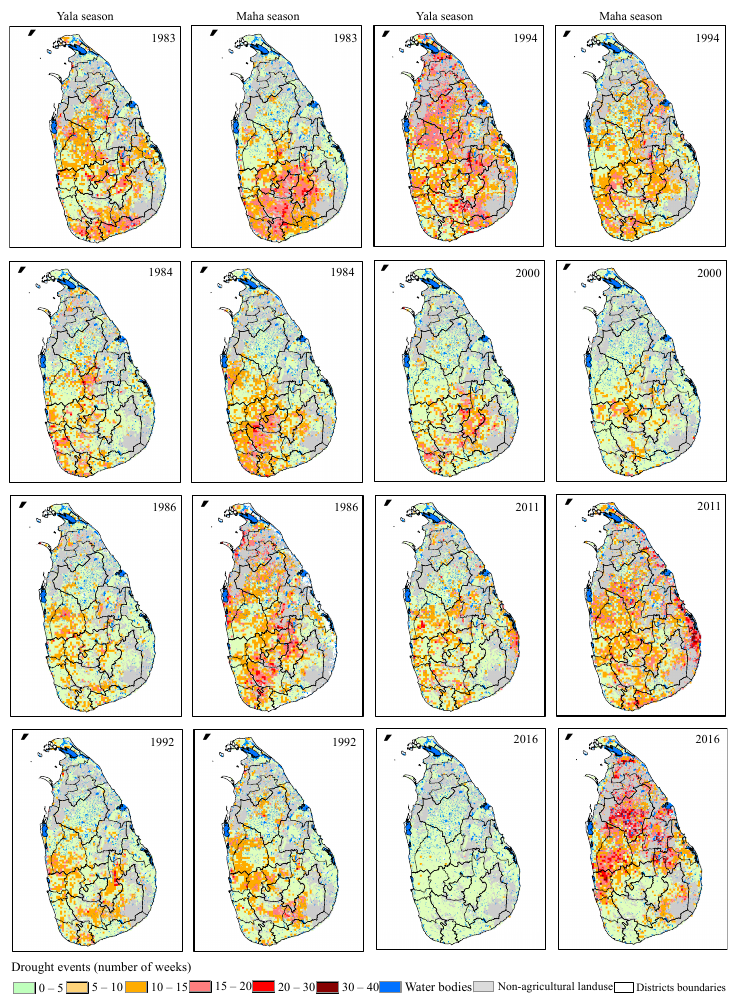
Figure 6. Historical drought years identified based on the number of weeks with severe to extreme drought conditions in Yala and Maha crop growing seasons.